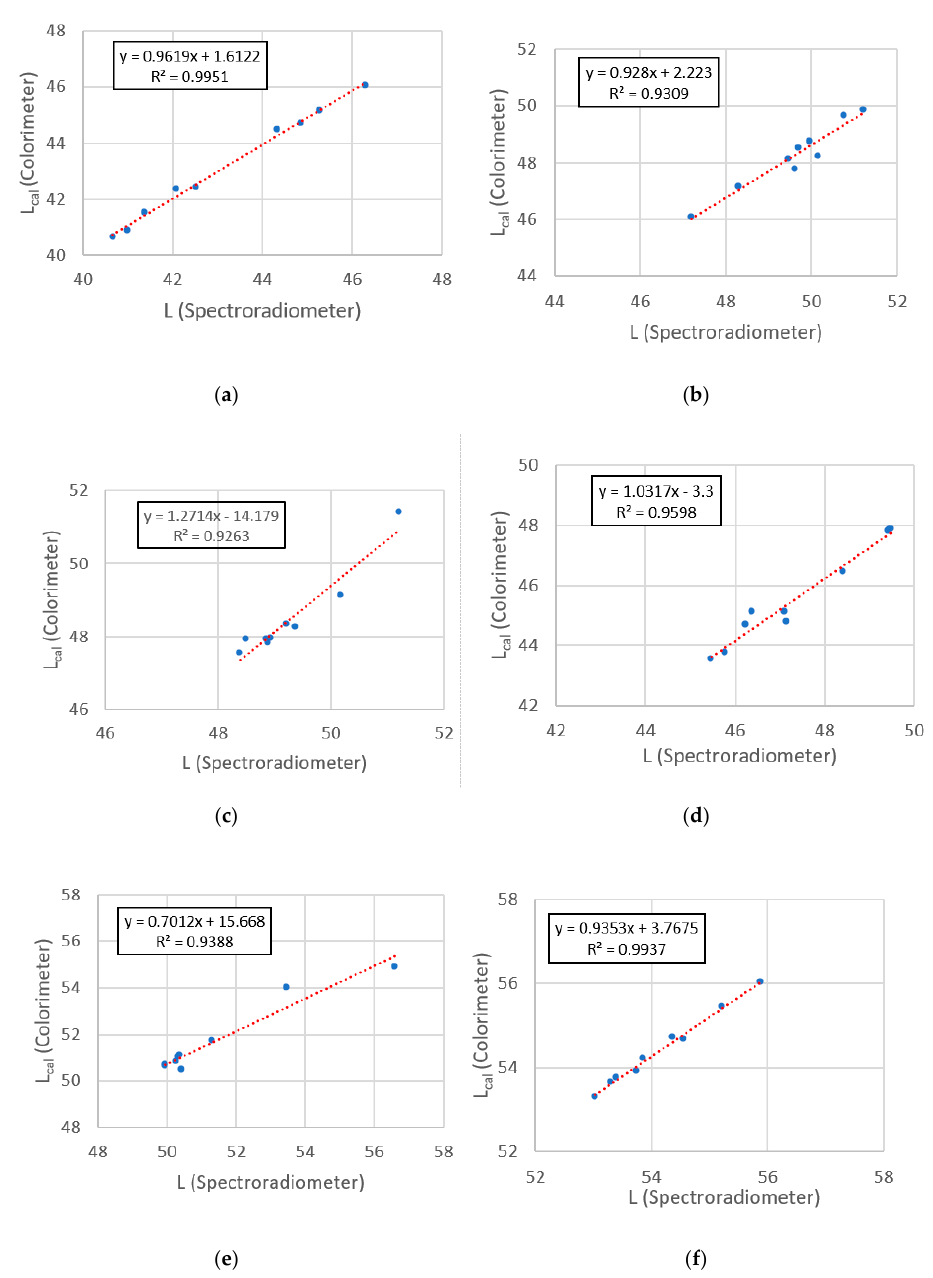
Figure 7. Validation plots for each study area between calibrated colorimeter data and spectroradiometer data for Study Area A1 ( a ), Study Area A2 ( b ), Study Area B1 ( c ), Study Area B2 ( d ), Study Area C1 ( e ), Study Area C2 ( f ). Table 5. R 2 and RMSE produced through validation